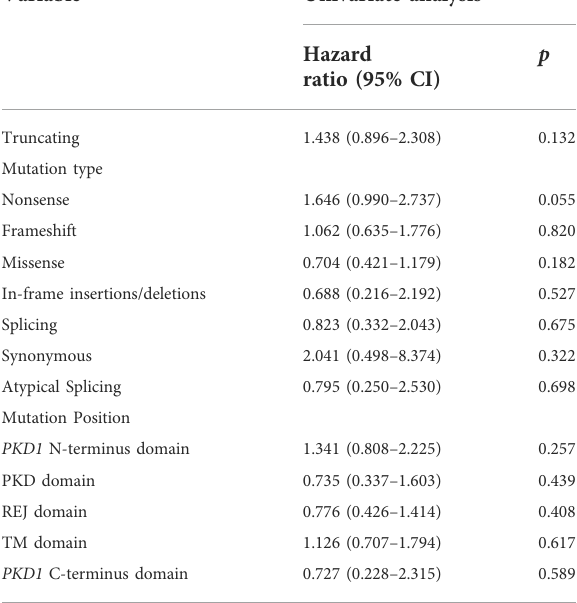
TABLE 2 Univariate analysis of risk factors related with RRT in the PKD1 cohort.